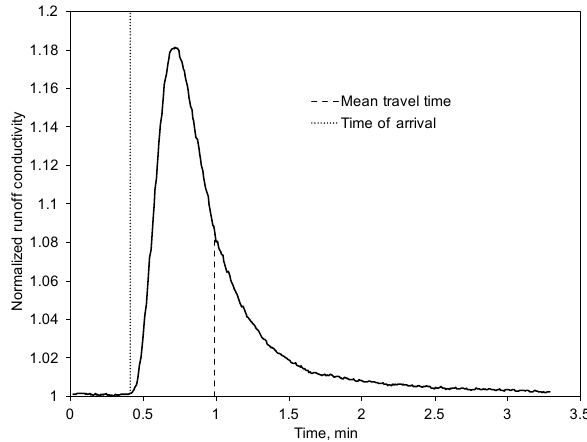
Figure 3. Typical hydrograph of a rainfall simulation